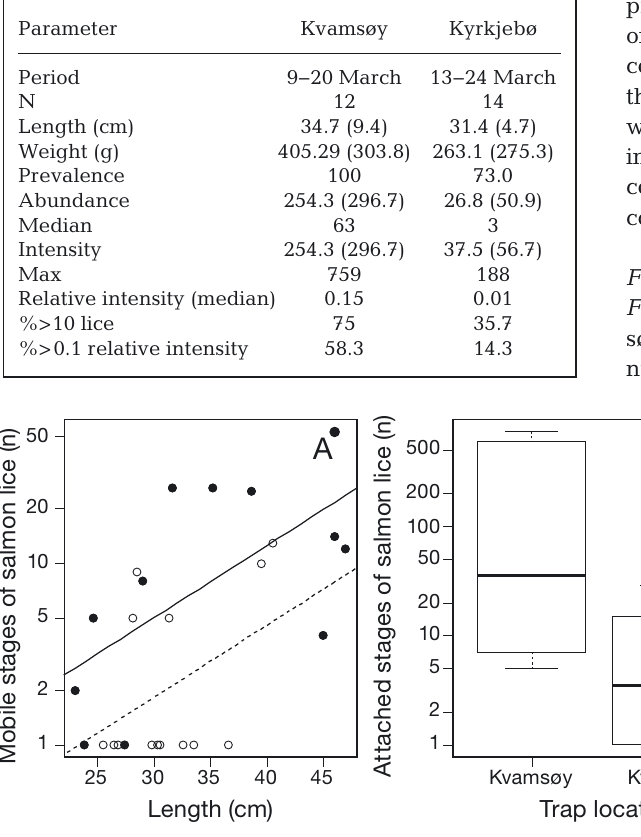
Fig. 2. Salmon lice Lepeophtheirus salmonis abundance on sea trout Salmo trutta sampled in March 2014 and enumerated in the laboratory. (A) Mobile stages of salmon lice versus length of sea trout, showing the modelled relation- ship for Kvamsøy (solid line and black circles) and Kyrkjebø (dashed line and open circles). (B) Boxplot of attached stages according to sea trout trap location. Horizontal lines: median, boxes: range between first and third quartile, error bars: range of data, open circles: outliers. Please note that we added 1 to the values to enable log-transformation of the data, and the scale is